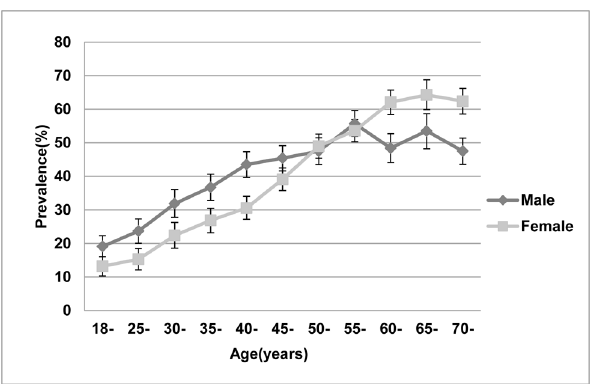
Figure 2. Prevalence of CVD risk factor clustering by age and gender. The prevalence (and 95% confidence intervals) of clustering of CVD risk factors was calculated for various age groups and for both sexes (male or female). All prevalence rates were adjusted